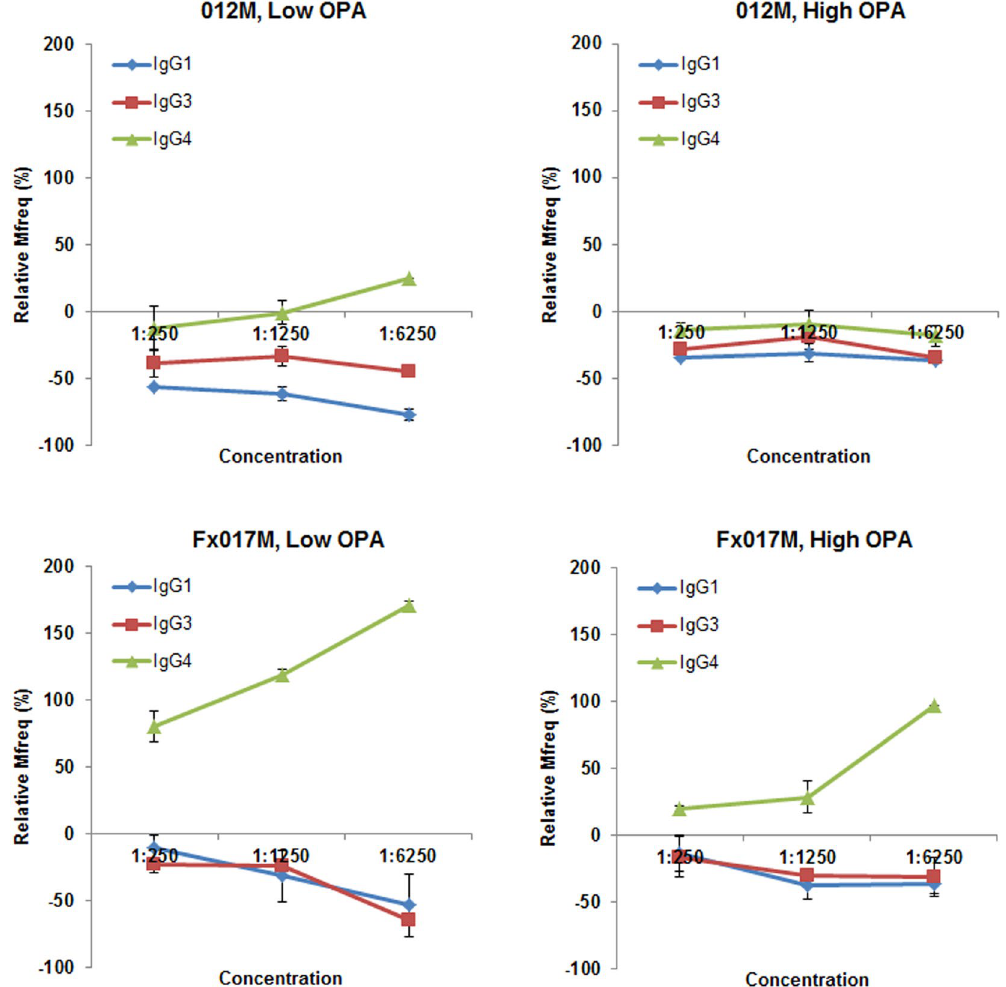
Figure 5. Serum opsonophagocytic activity following depletion of IgG isotype subclasses at a range of serum concentrations. The change in Mfreq relative to the non-depleted sample is shown following depletion of IgG1, IgG3, and IgG4 for the low-OPA and high-OPA pools for the 012M and Fx017M